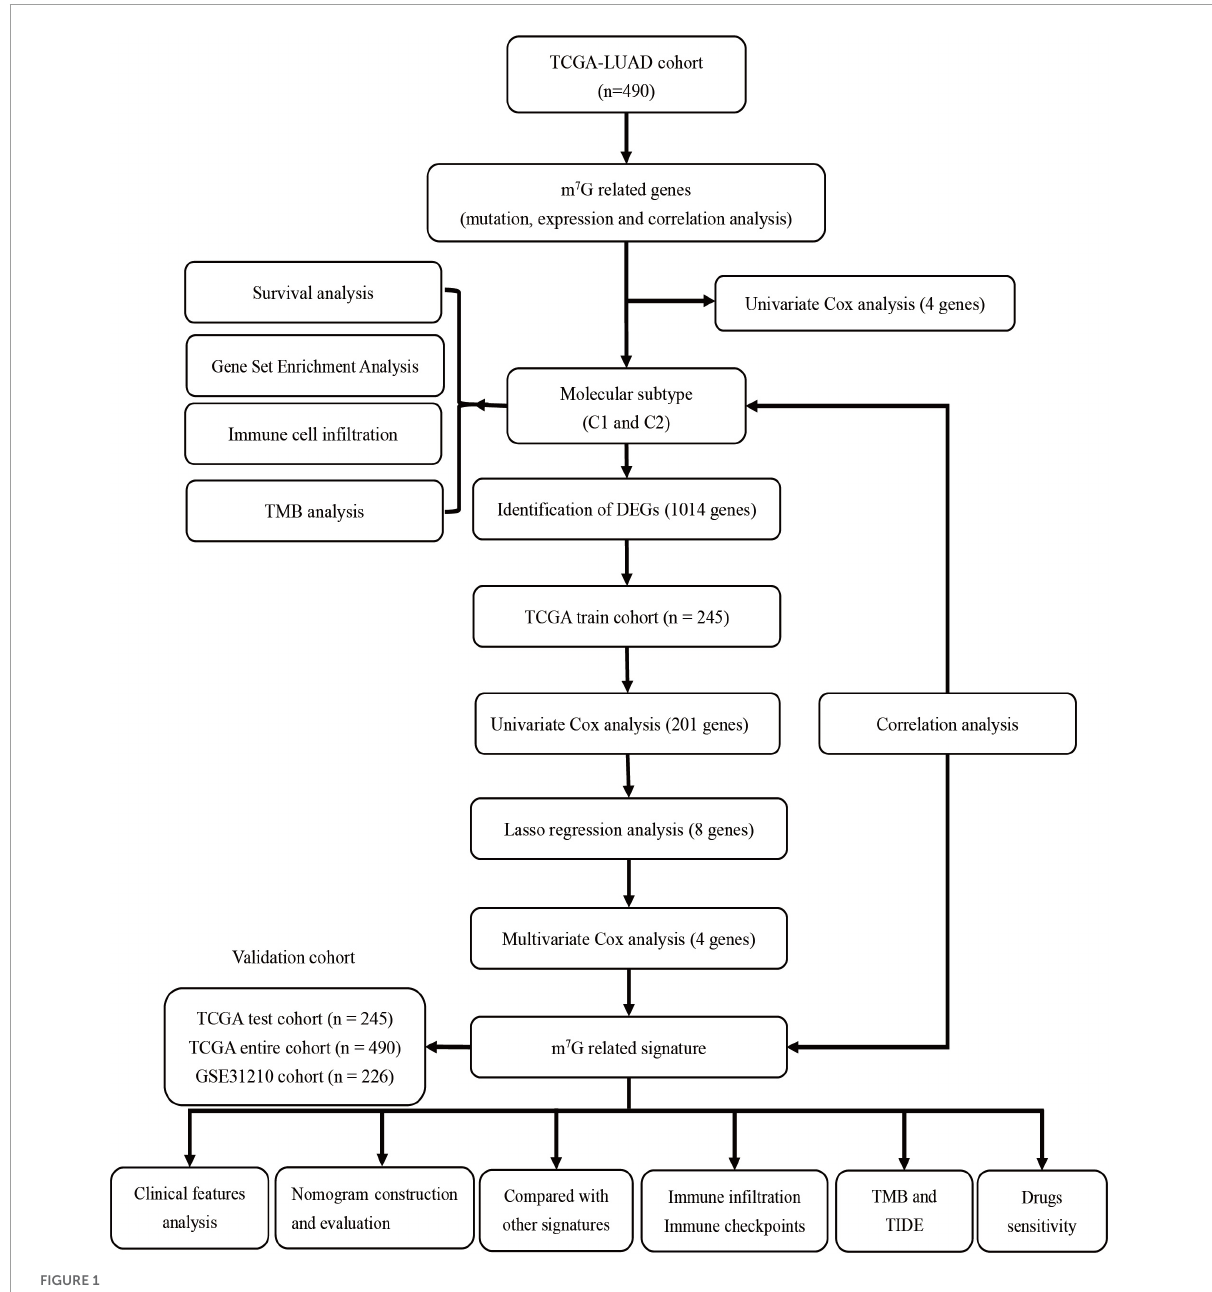
FIGURE1 The flowchart of the overall study.